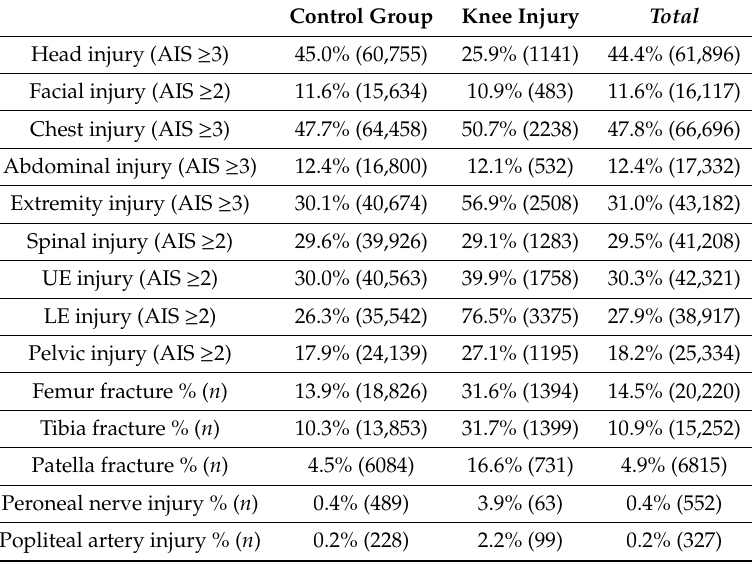
Table 3. Patterns of